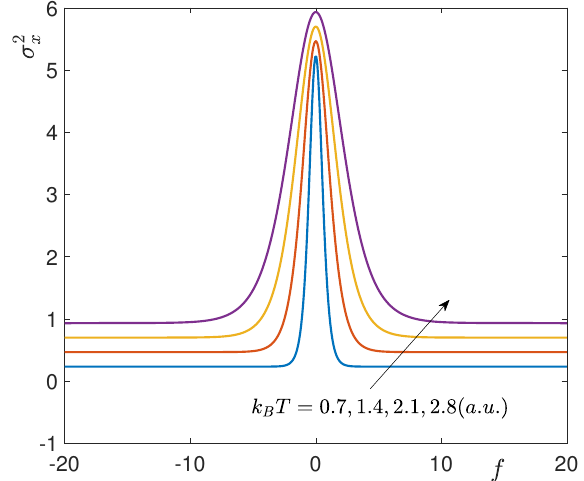
Figure 7. Variance of x N obtained by the Gibbs density (cid:36) G ( x N ; f ) . As before, we used N = 5, (cid:96) = 1 (a.u.), k = 15 (a.u.) and k B T = 0.7, 1.4, 2.1, 2.8